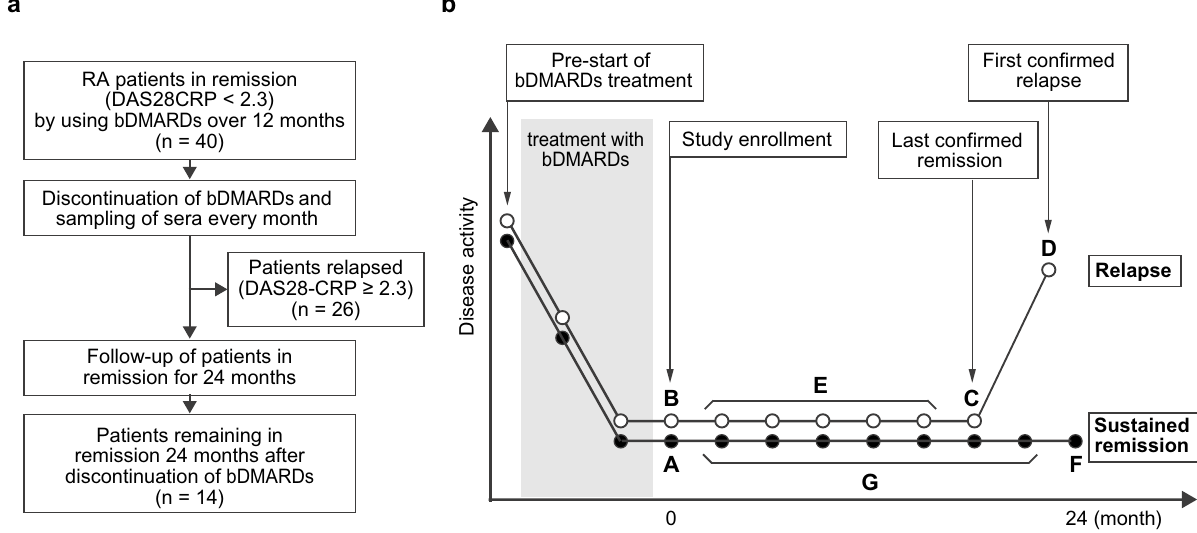
Figure 1. Study design. ( a ) Flow chart of patient enrollment. RA patients in remission judged by DAS28-CRP for at least 12 months by using bDMARDs were included. After discontinuation of bDMARDs, those patients were followed, and serum samples were collected monthly. Follow-up period spanned up to 24 months if the patients stayed in remission. ( b ) Schema of the timing of clinic-visits and serum sampling. Points A and B are the time of study initiation for the non-relapsed (sustained remission) and relapsed groups, respectively. Points C is the time of the last confirmed remission and D is the time of the first confirmed relapse and the study-end in the relapsed group. E points are the time of monthly clinic-visits in the relapsed group while in remission. Point F is the time of the study-end for the non-relapsed group. G points are the time of monthly clinic-visits in the non-relapsed group. The images were created using Adobe Illustrator (ver. 25.4.1, https:// www. adobe.